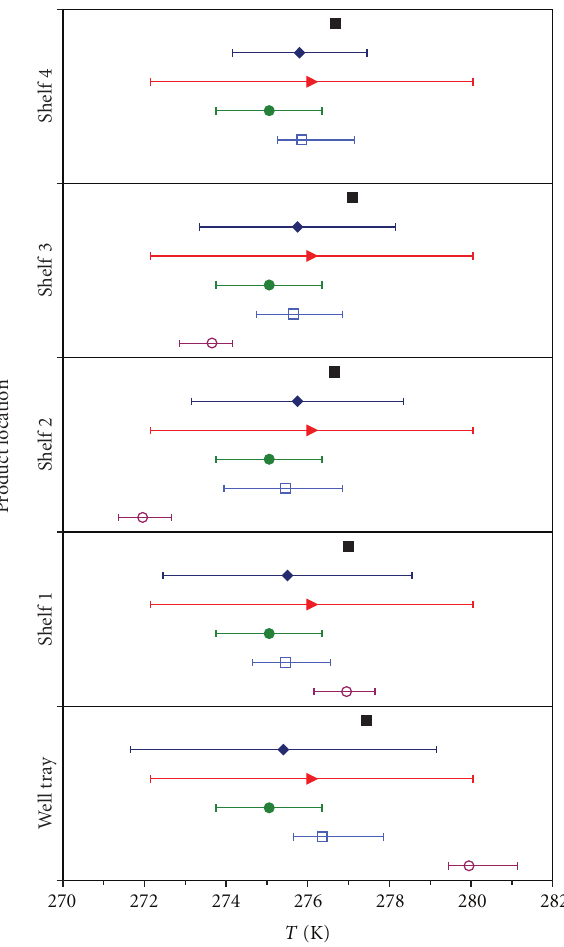
Figure 6: Comparative profiles of internal product temperature, T ( y / W = 0.33, z / H )